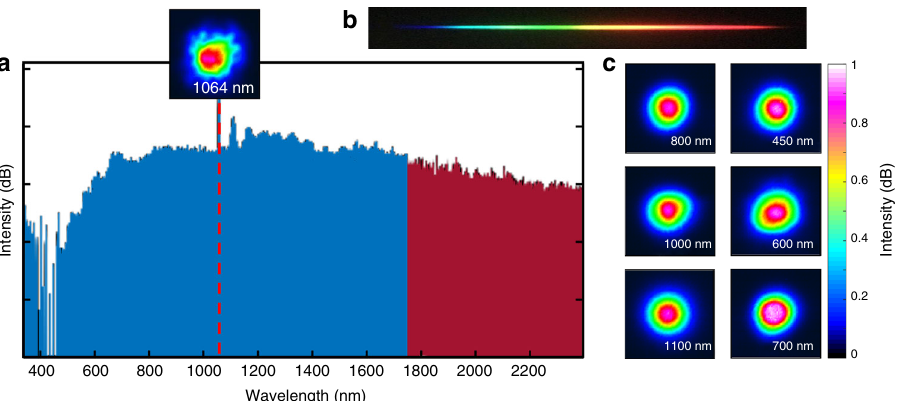
Fig. 7 Experimentally obtained supercontinuum spectra from a tapered parabolic-index multimode fi ber. a The output supercontinuum spectrum after a 15-m long graded-index multimode fi ber when its core radius is reduced from 40 to 10 µ m. The fi ber is excited at 1064 nm in the normal dispersion regime with an input pulse of 400 ps and a peak power of 180 kW. The spectrum happens to be relatively fl at, extending from 450 to 2400 nm (more than 2.5 octaves), and was recorded using two different optical spectrum analyzers (blue trace from 350 to 1750 nm, and red trace from 1750 to 2400 nm). Every scale division corresponds to 10 dB. The pump beam pro fi le is shown as an inset. b A photograph image of the visible component of the dispersed output spectrum. c The beam pro fi les recorded at different wavelengths of the output supercontinuum. All the beam pro fi les appear clean and speckle-free, with a signi fi cant amount of power residing in the fundamental